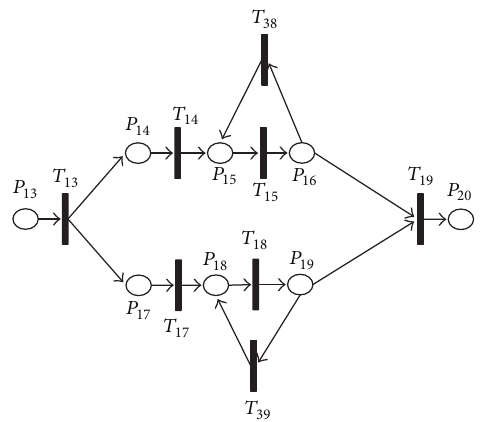
Figure 12: Optimized Petri net model of matching process.